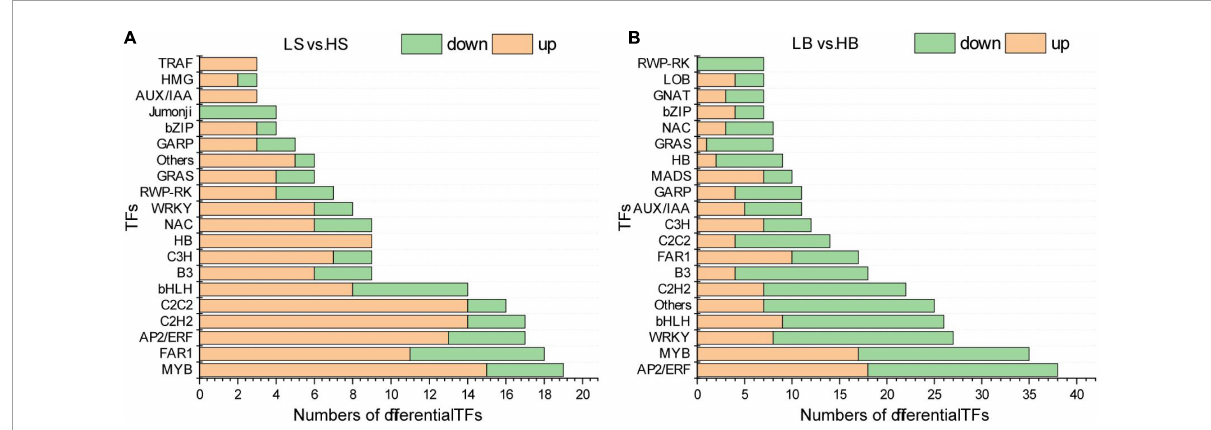
FIGURE7 Differential transcription factors involved in drought stress (the top 20 differentially expressed were selected). (A) Different transcription factors of H. ammodendron involved in drought stress; (B) different transcription factors of H. persicum involved in drought stress. LS and LB, respectively, represent H. ammodendron and H. persicum in an arid environment; HS and HB denote H. ammodendron and H. persicum , respectively, under a humid